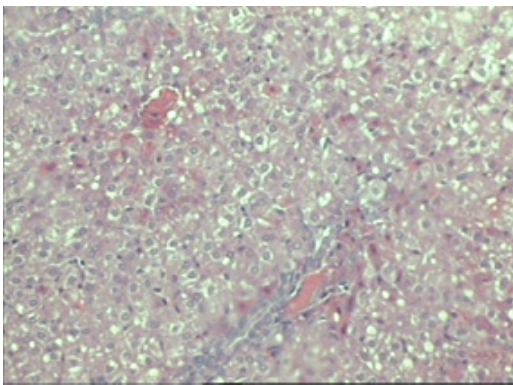
FIGURE 2 - Histological findings of the receipts (HE 100x).